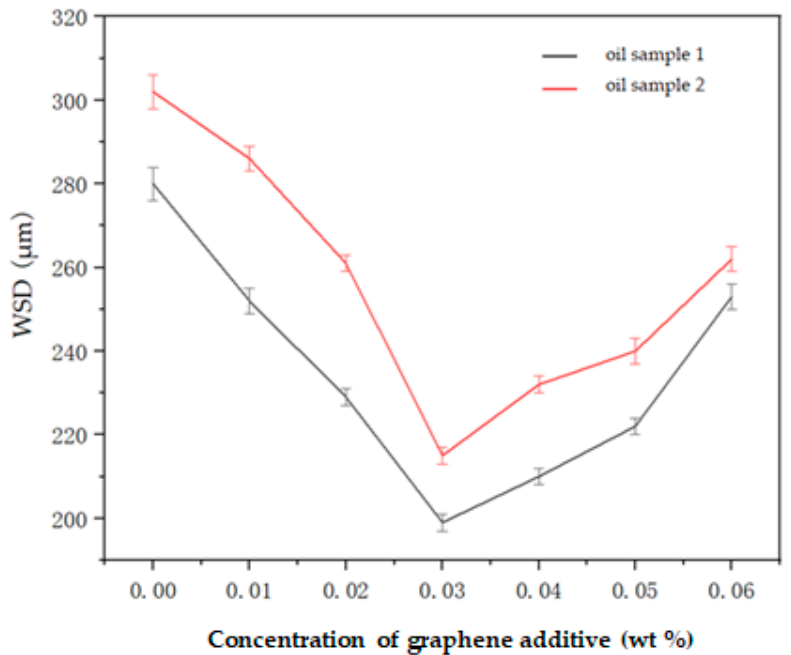
Figure 10. The wear scar diameter (WSD) of 0# diesel oil (oil sample 1 and oil sample 2) with different concentrations of graphene additive.